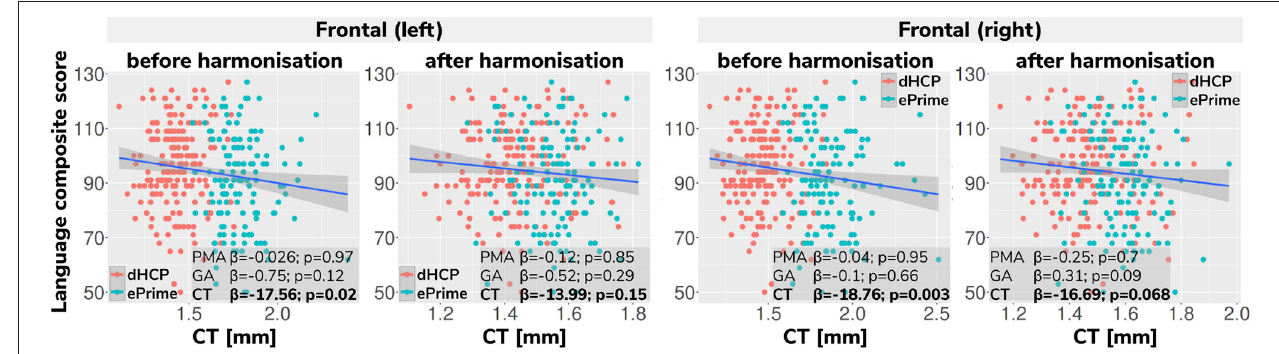
FIGURE 13 | Language composite score against predicted left and right frontal cortical thickness measures before and after harmonizing the tissue segmentation maps. Without harmonization (columns 1 and 3) there appears to be a significant association between left or right frontal cortical thickness and language abilities, but after harmonization (columns 2 and 4) the effect of cortical thickness on language ability is rendered non-significant in both left and right frontal cortex. This demonstrates the importance of data harmonization without which pooling images from separate datasets can lead to spurious findings that are driven by differences in acquisitions rather than by true underlying